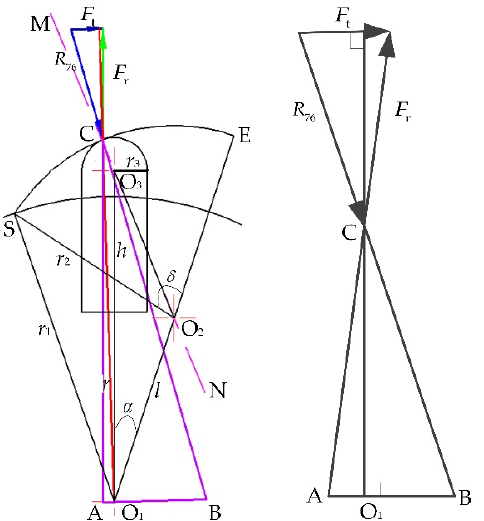
Figure 6. The force analysis of the contact between the single locking tab and the locking ring in the holding process.